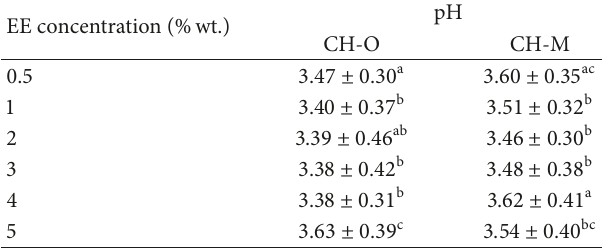
Table 3: pH values of film forming solutions with various degrees of EE concentrations. EE concentration